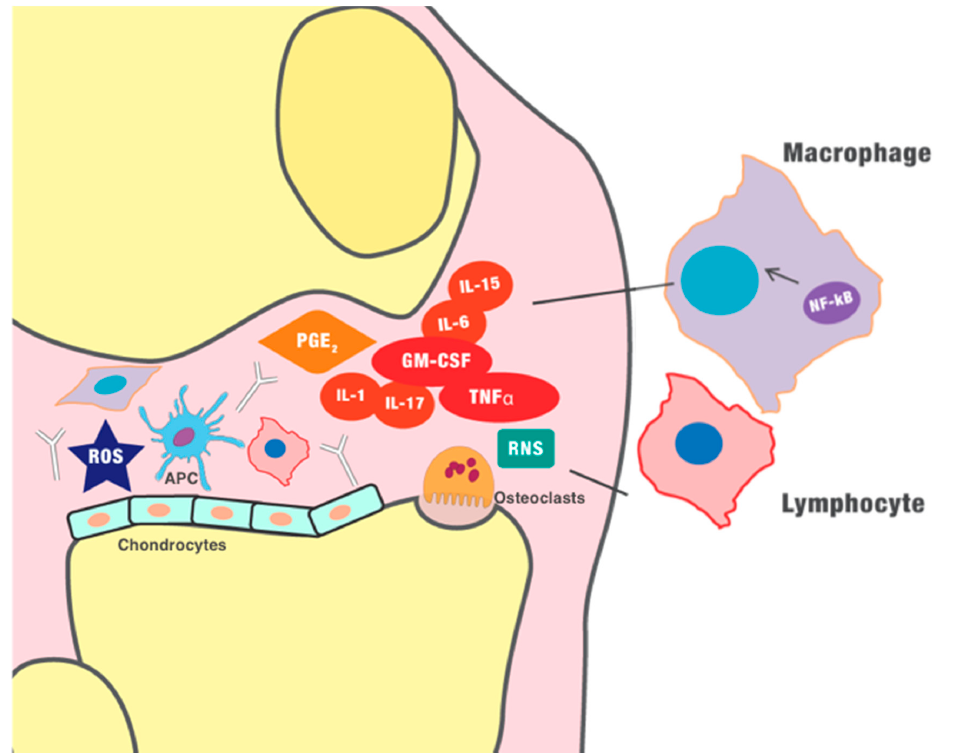
Figure 2. Pathogenesis of inflammatory arthritides. Self-reactive T helper cells seem involved in the maintenance of inflammation, further sustained by B cells, especially in rheumatoid arthritis (RA), where it is possible to detect autoantibodies (